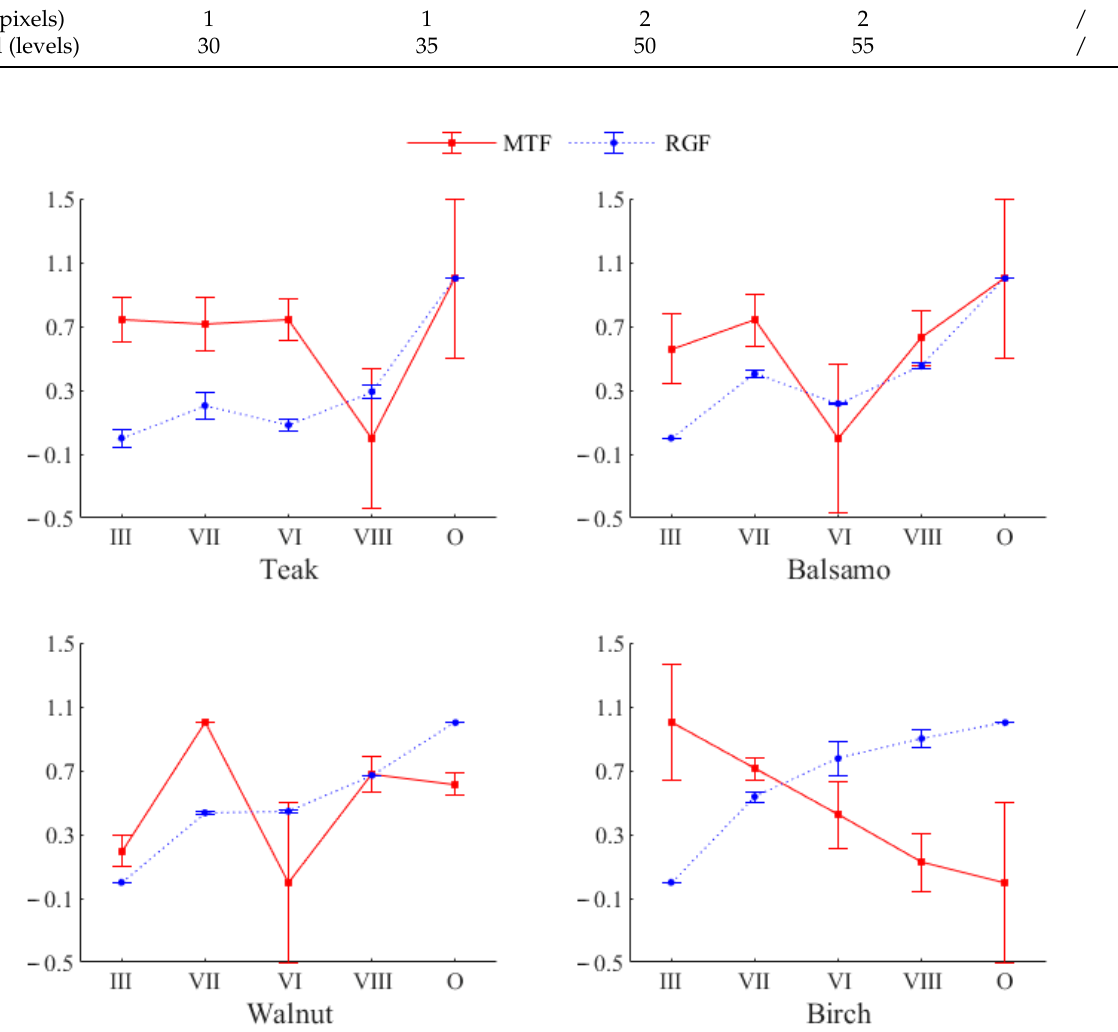
Figure 3. The changing trends of normalized MTF and RGF values under reset denoising schemes. O represents original images.